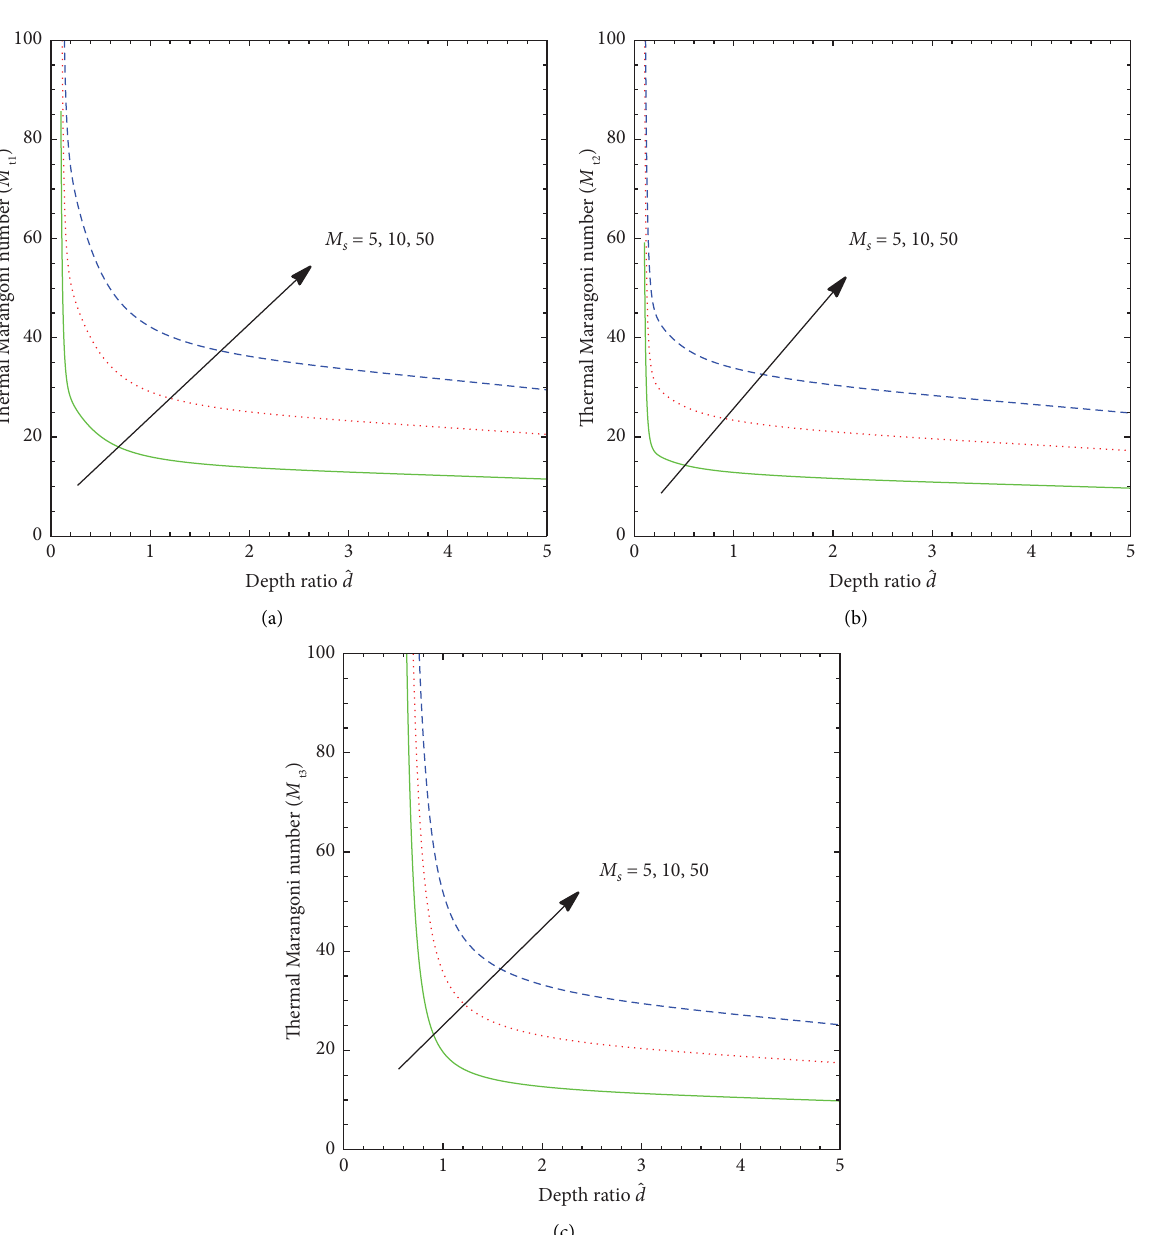
� 5 , 10 , 50 when a S